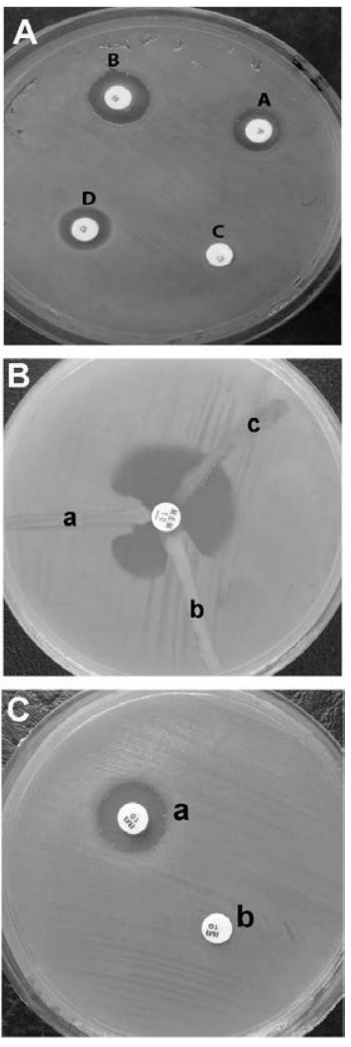
Fig. 2. The result of phenotypic detection of AmpC, ESBL (A) KPC (B) and MBL (C) strains of clinical isolates of P. aeruginosa and A. baumannii . A: For ESBL positive: B - A and D - C ≥5mm, D - B and C - A < 5mm. For AmpC positive: B - A and D - C <5mm, D - B and C - ZA ≥ 5mm. For AmpC and ESBL positive: D - C ≥ 5mm, ZB - ZA < 5mm. For AmpC and ESBL negative: Difference of the zones ≤ 2mm. B: The Modified Hodge test performed on a Muller Hinton Agar plate. a: MHT positive result; b: a clinical isolate; and c: negative result. A 10μg meropenem (MEM 10μg) or ertapenem susceptibility disk is placed in the center of the test area. C: Combined EDTA disk diffusion test: In the combined disc test, if the increase in inhibition zone with the Imipenem+EDTA disc (a) was ≥ 7 mm than the Imipenem disc (b) alone, it was considered as MBL